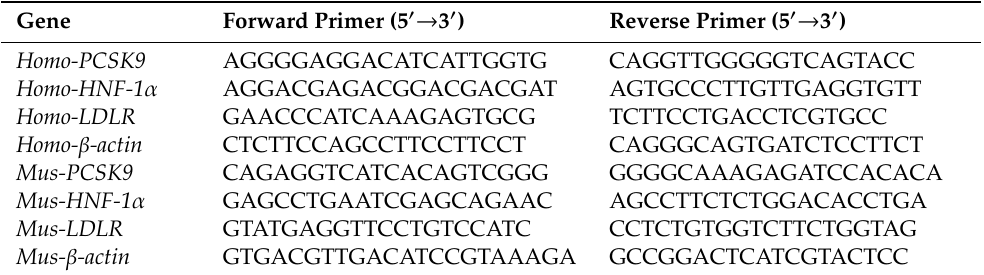
Table 1. Primer sequences used for